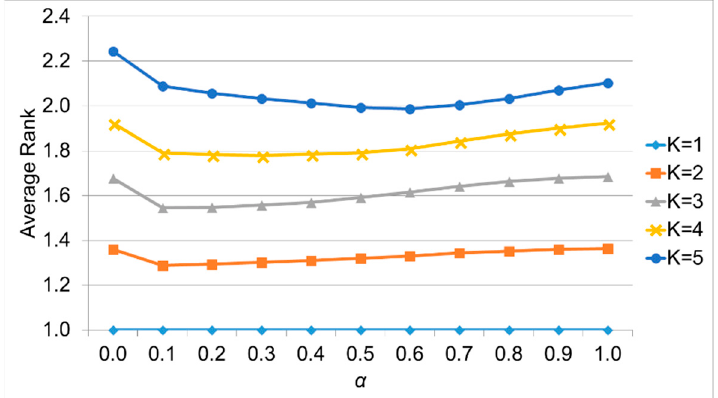
Figure 4. Average rank as the weight parameter changed.